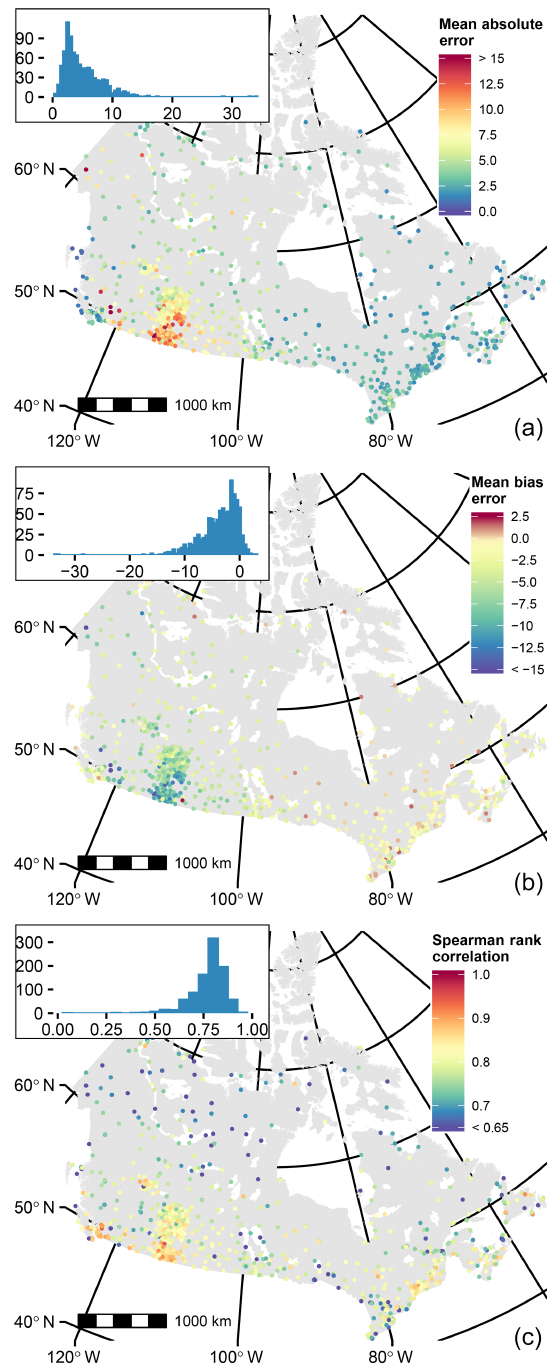
Figure 2. Validation of FWI values calculated from the ERA5 reanalysis compared with observed FWI values calculated from ECCC station data for 1979–2009. Spatial distribution and his- togram values are shown for the mean absolute error (a) , mean bias error (b) , and Spearman rank correlation (c) . Map displayed in Atlas of Canada Lambert conformal projection